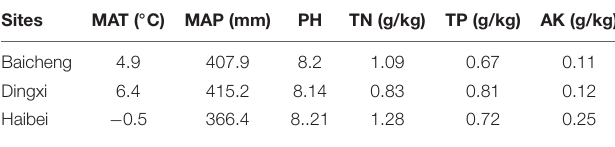
TABLE 1 | Meteorological information and soil properties data for three different locations of oat seed production in 2018.